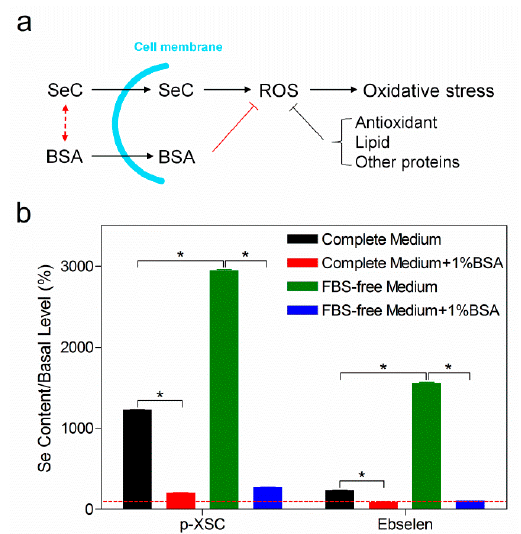
Figure 2. E ff ect of albumin on the cellular uptake of selenocompounds. ( a ) The SeC enters the cell and generates reactive oxygen species (ROS), inducing oxidative stress and subsequent cell death. BSA might interfere with SeC cytotoxicity through two mechanisms: (1) binding SeC extracellularly (the red dash line with arrows) and modulating the uptake; (2) neutralizing intracellular ROS (the red solid line with end; T-bar) and relieving oxidative stress without a ff ecting uptake. Other cellular components including antioxidant, lipids, and other proteins are also capable of neutralizing ROS (the gray solid line with end; T-bar). ( b ) Intracellular Se level after p-XSC (10 µ M) or ebselen (20 µ M) treatment for 30 min. The treatments were performed in complete medium (black bar), complete medium supplemented with 1% extra BSA (red bar), FBS-free medium (green bar), or FBS-free medium supplemented with 1% extra BSA (blue bar). Results are shown as the mean ± standard deviation of three technical replicates. The red dashed line marks the basal level from untreated cells. Two-sided Mann–Whitney test was applied to compare the means between groups. * denotes p ≦ 0.05.